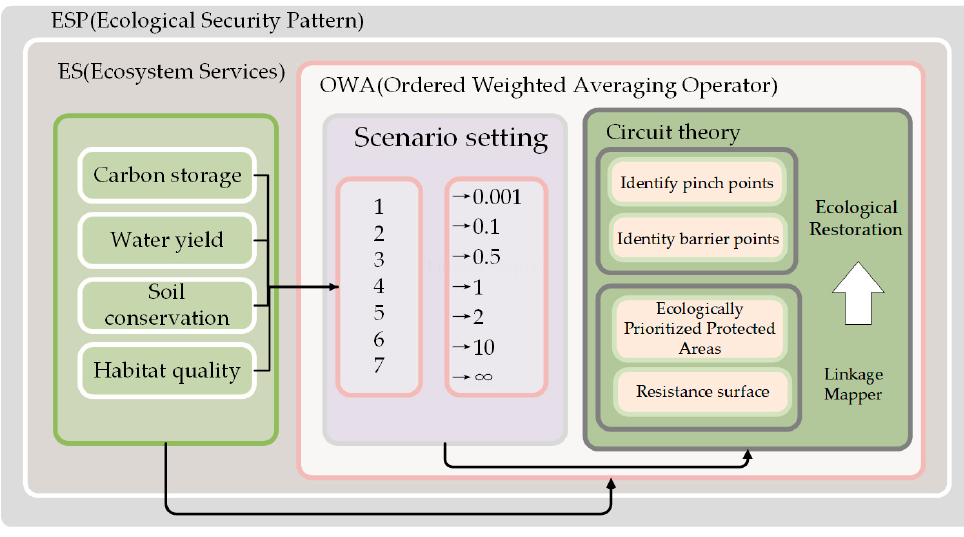
Figure 2. Methodology framework and design.